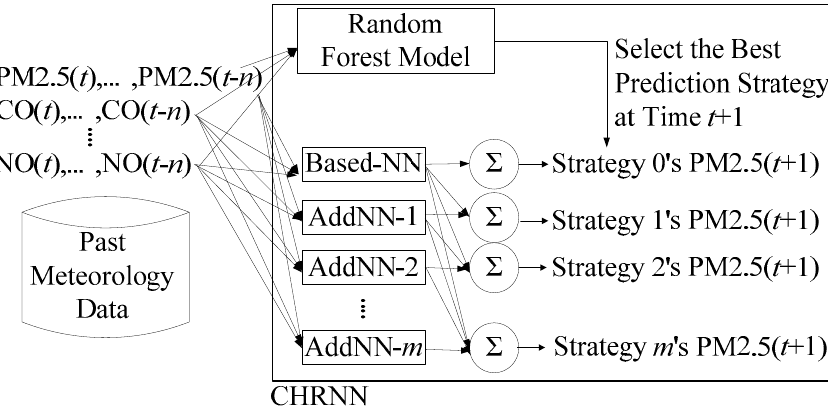
Figure 1. Operation of combinational Hammerstein recurrent neural network (CHRNN), in which meteorological data are the input and predicted particulate matter 2.5 (PM2.5) values are the output. The CHRNN includes a central based-neural network (based-NN) and several add-on neural networks (AddNNs) capable of generating multiple prediction strategies, making it an ideal approach to dealing with the complexity of PM2.5 prediction.